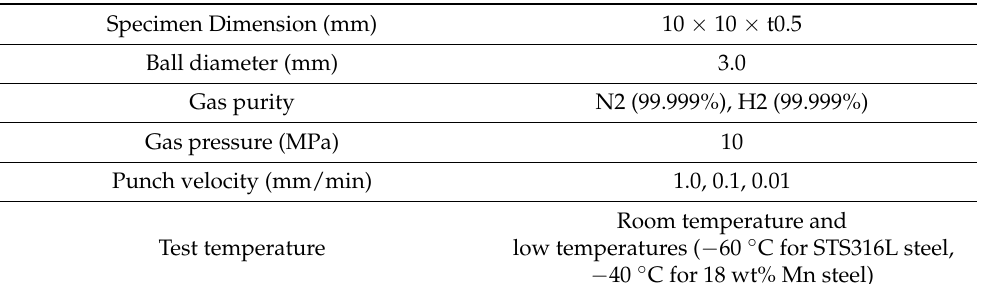
Table 4. Test conditions applied during the in-situ small punch tests used to examine the effects of surface roughness on hydrogen embrittlement